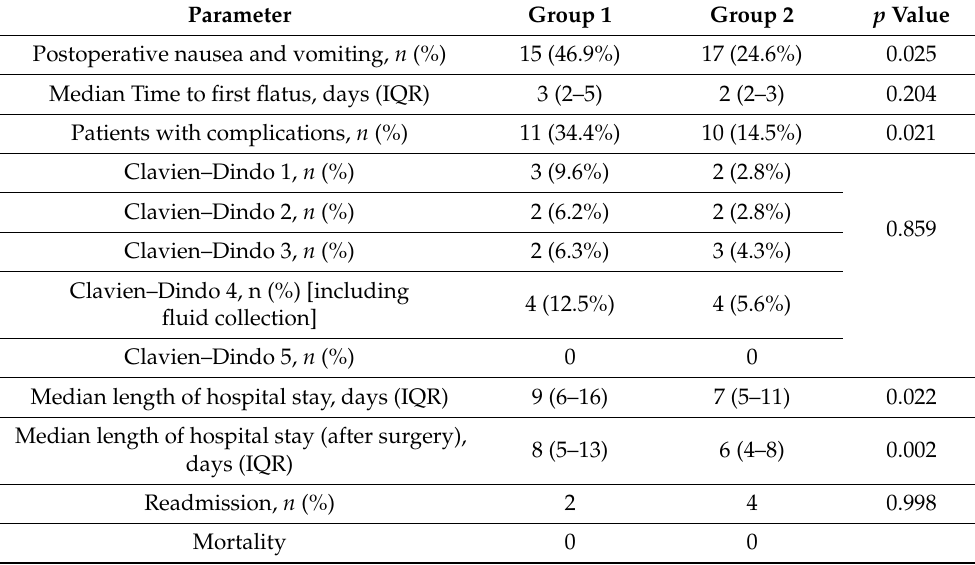
Table 4. Postoperative outcomes in analyzed